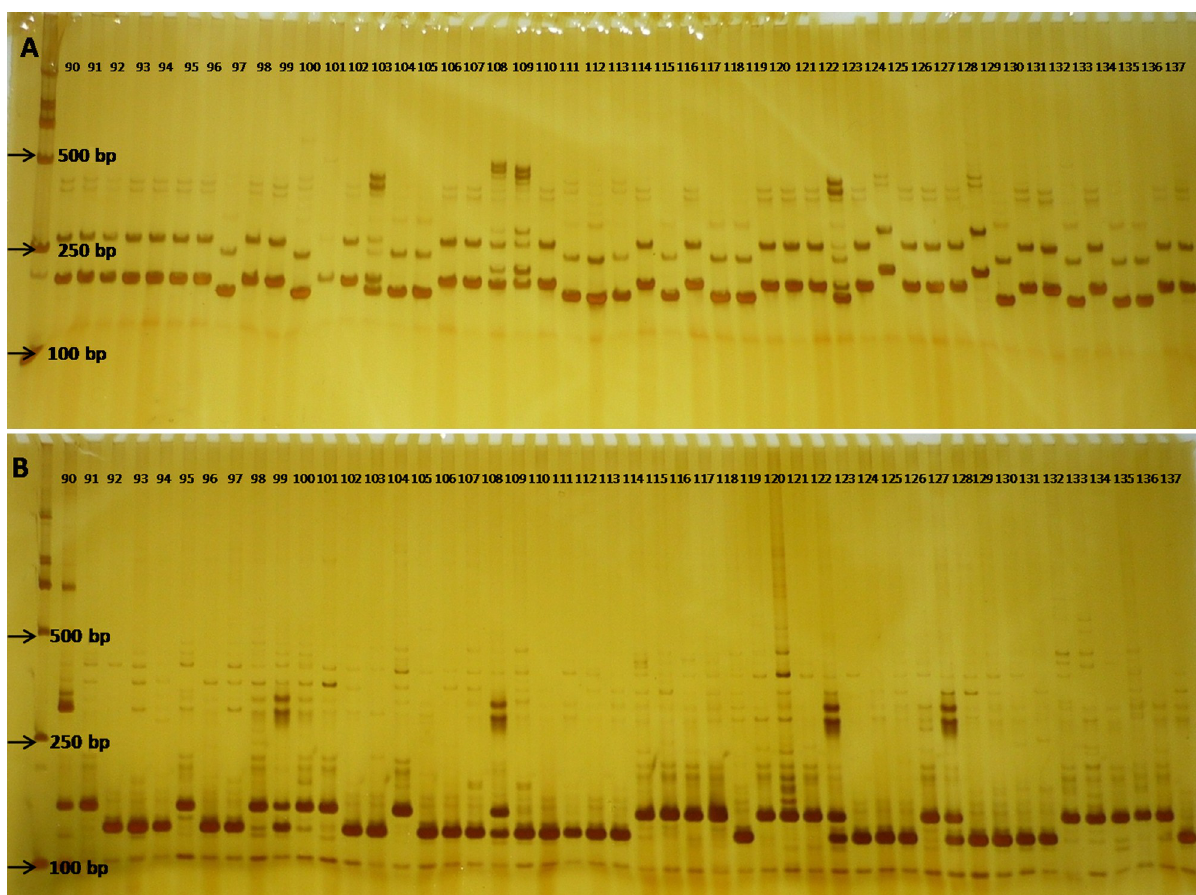
Fig 1. Gel pictures display profile results of SSR markers (A, Ol11H02) and (B, Ol11G11) amplified from some cauliflower inbred lines.